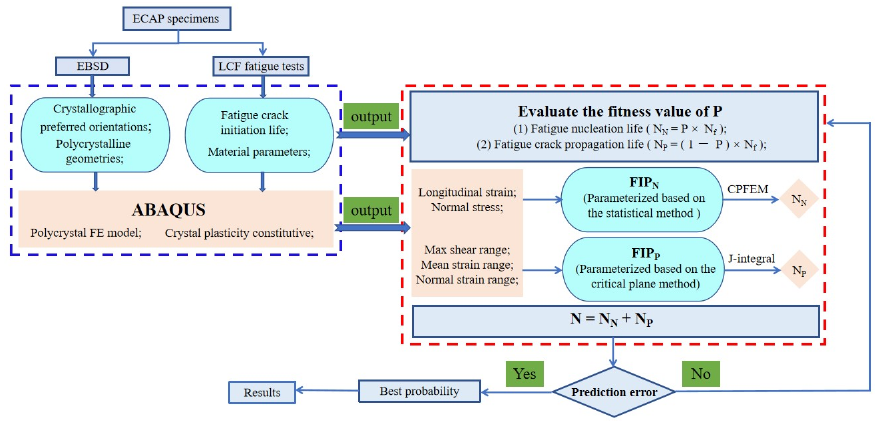
Figure 1. The technical diagram for the proposed method.